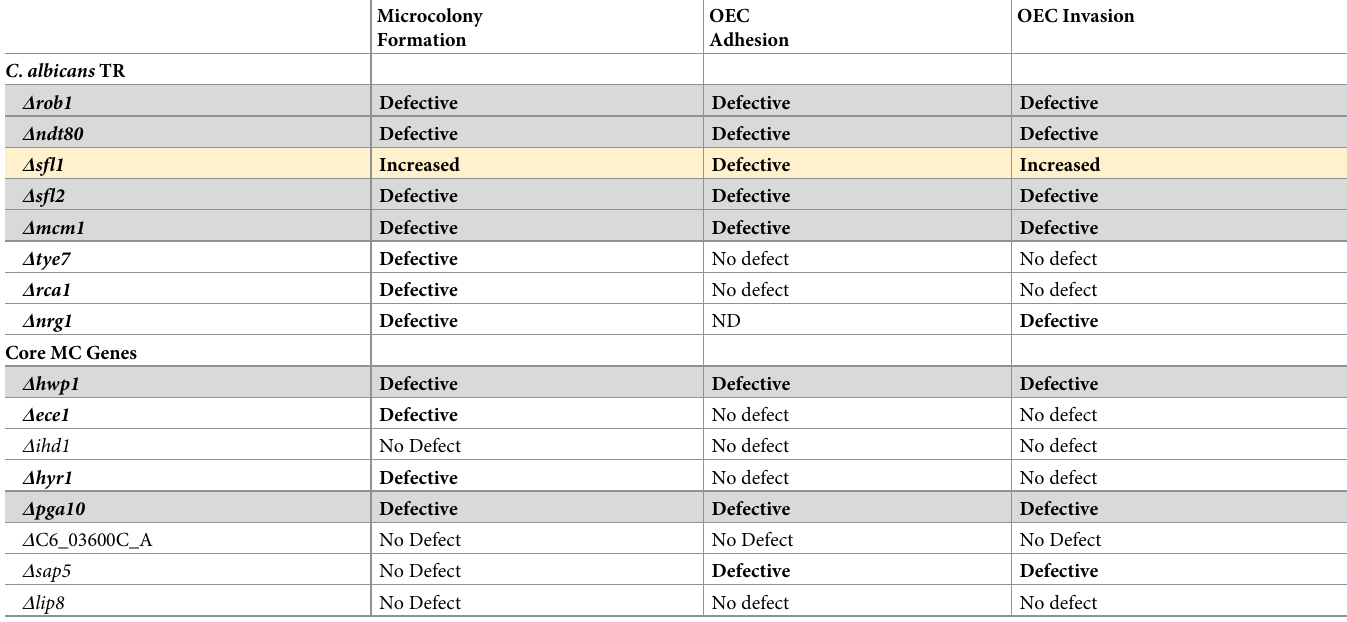
Table 3. Knockout of five transcriptional regulators (TR) and two core microcolony (MC) genes result in defects in microcolony formation and function. C . albicans deletion mutants were grown on oral epithelial cells (OEC); and microcolony formation, adhesion and invasion were measured. Significant ( p < 0.05) differences in micro- colony density, number of adhered cells, or percentage of cells actively invading were determined using one-way ANOVA followed by a post-hoc Tukey’s t-test (microcol- ony formation) or Bonferroni (adhesion and invasion). Strains highlighted in grey were defective in all three categories. ND: not determined. Microcolony OEC OEC Invasion Formation Adhesion Defective